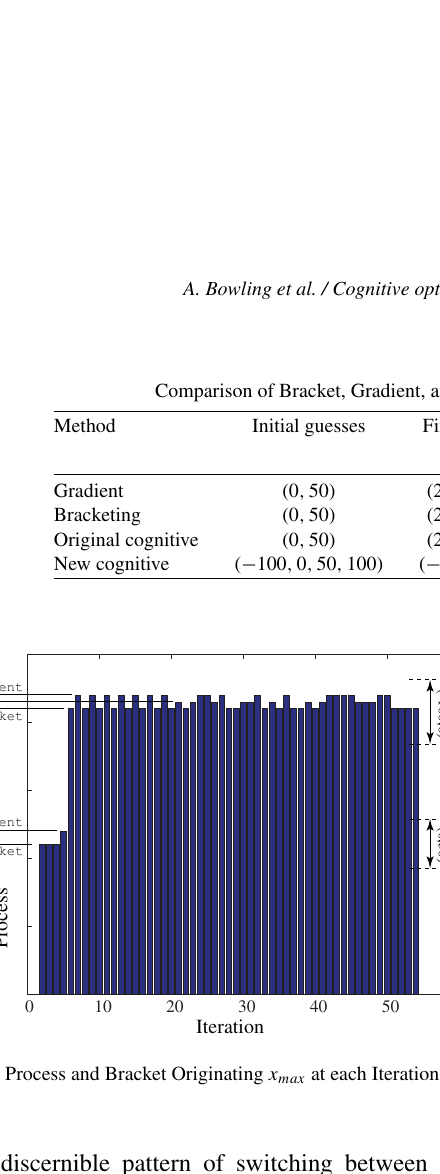
Fig. 15. f ( x ) = 2 / ( x 2 − x ). Properties: discontinuous, nonlinear, unconstrained, nonconvex, local optima,